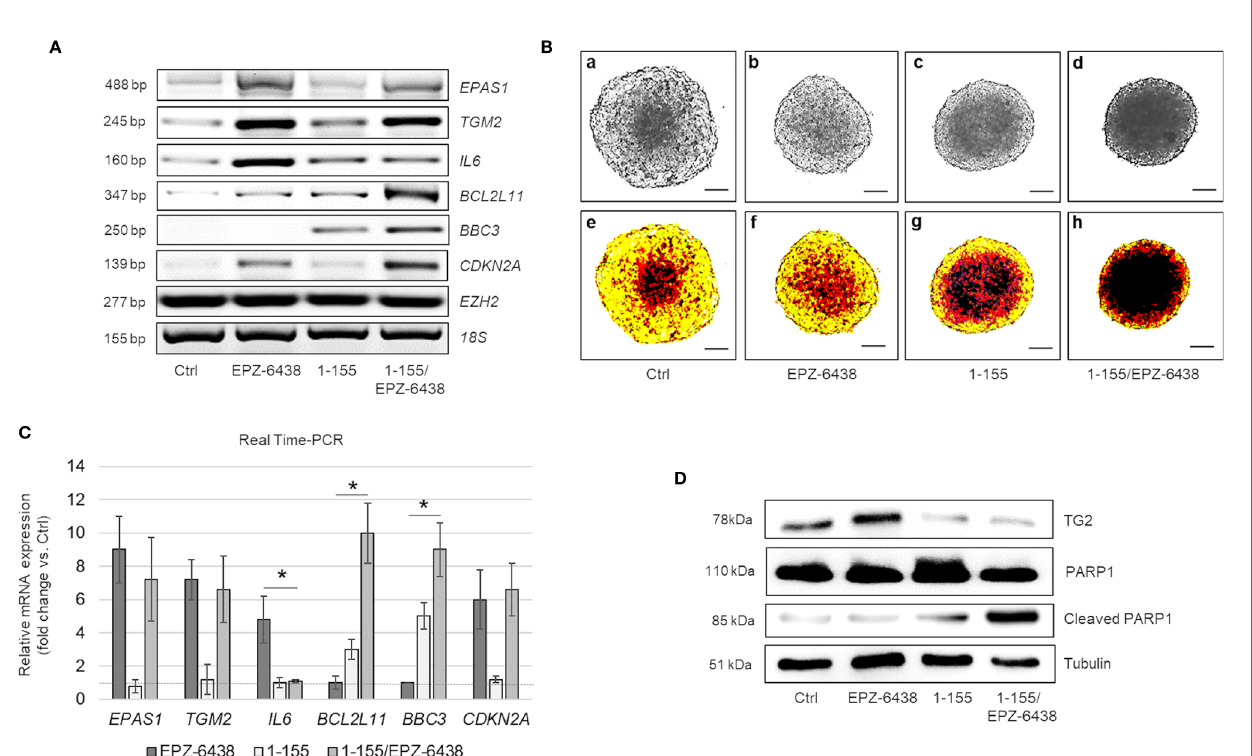
FIGURE 5 | Dual inhibition of TG2 and EZH2 exhibits pro-apoptotic synergy in MPM MCS. (A) Representative RT-PCR of EPAS1, TGM2, IL6, BCL2L11, BBC3, CDKN2A , and EZH2 expression in MSTO-211H MCS untreated or treated 48 h with EPZ-6438 and 1-155 as single agents or in combination. 18S rRNA was used as housekeeping gene. (B) Representative phase contrast images (×40 magni fi cation) (one of 12) (a – d) and relative pseudo-color images (e – h) of MSTO-211H MCS untreated or treated 48 h with EPZ-6438 and 1-155 as single agents or in combination. Scale bar = 100 m M. (C) Real Time PCR (qPCR) analysis of EPAS1, TGM2, IL6, BCL2L11, BBC3 and CDKN2A expression in MSTO-211H MCS untreated or treated 48 h with EPZ-6438 and 1-155 as single agents or in combination. 18S rRNA was used as housekeeping gene. Each bar represents mean of three independent experiments ± s.d., *p ≤ 0.05. (D) Representative Western blot analysis of TG2, PARP1 and cleaved PARP1 in MSTO-211H MCS untreated or treated 48 h with EPZ-6438 and 1-155 as single agents or in combination. Tubulin was used as loading